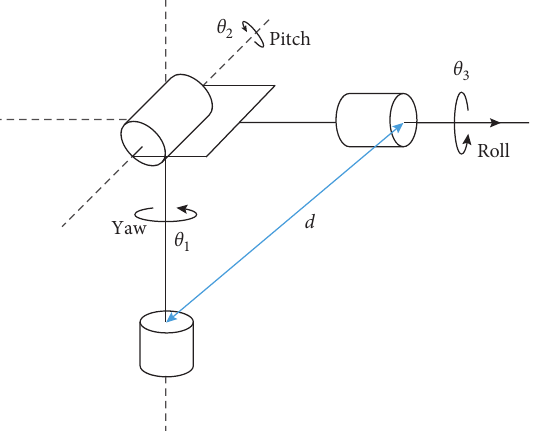
Figure 4: Schematic of inverse kinematics of the robot